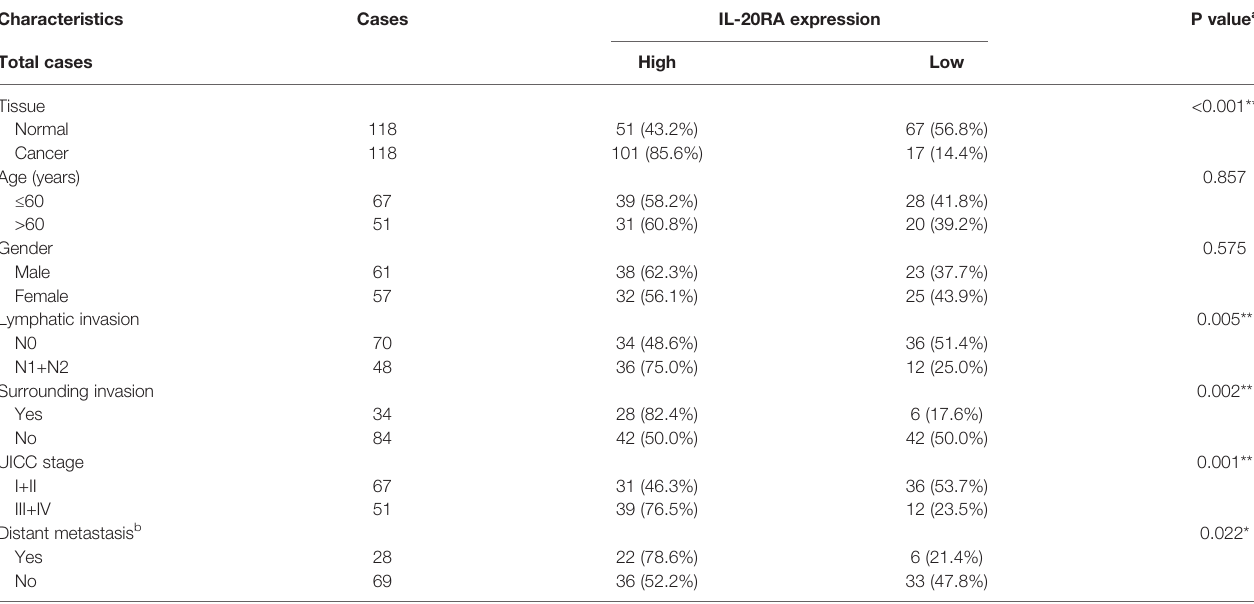
TABLE 1 | Correlation between IL-20RA expression and clinical characteristics in 118 colorectal cancer tissues.